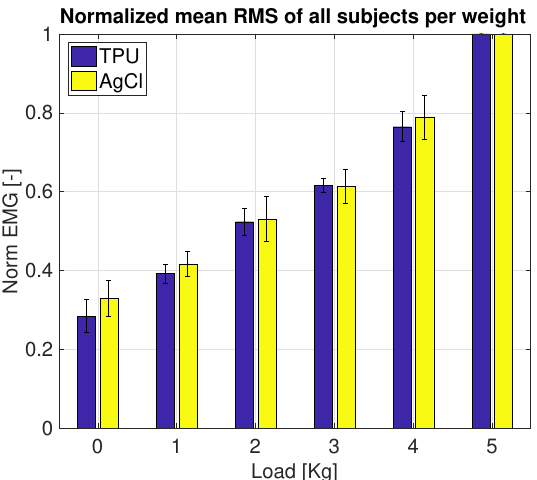
Figure 13. Mean envelope and standard deviation of all subject per